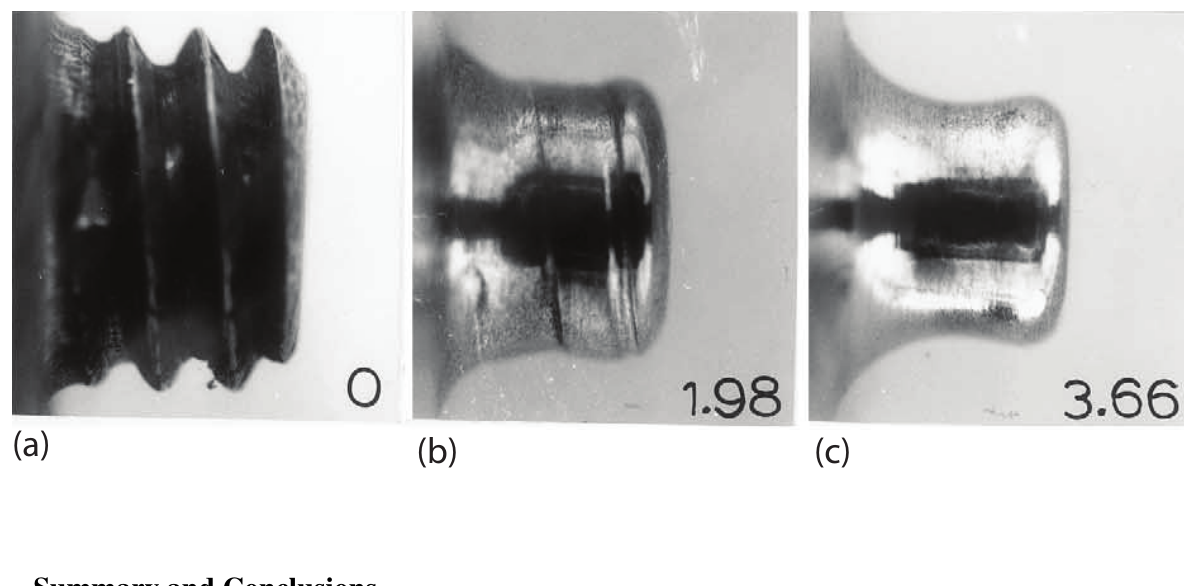
Figure 16 . Macroscopic images showing the wear of friction stir processing tool (after Prado et al. [58]); (a) the screw tool pin before FSP, (b) after traveling 1.98 m, (c) after